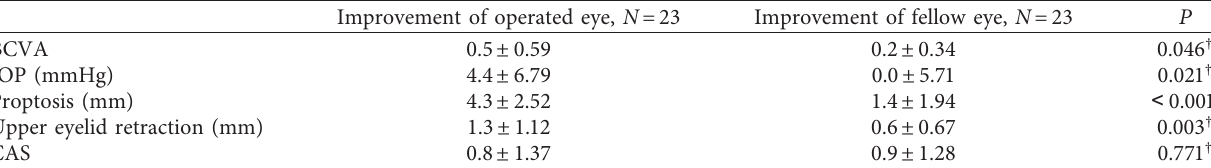
Table 3: Improvement of clinical parameters of the operated eyes and fellow eyes after treatment in patients with bilateral DON.